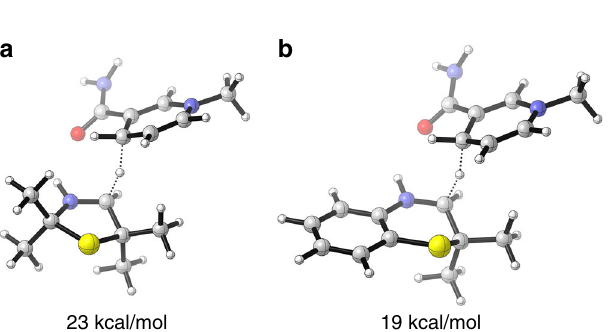
Fig. 6 DFT studies. Transition states obtained by DFT calculations for the reduction of the non-substituted protonated 3-thiazoline ( a ) and protonated 2 H -1,4-benzothiazine ( b ) by means of a dihydropyridine mimic as a reducing agent (Gibbs free energies of activation Δ G 298K are